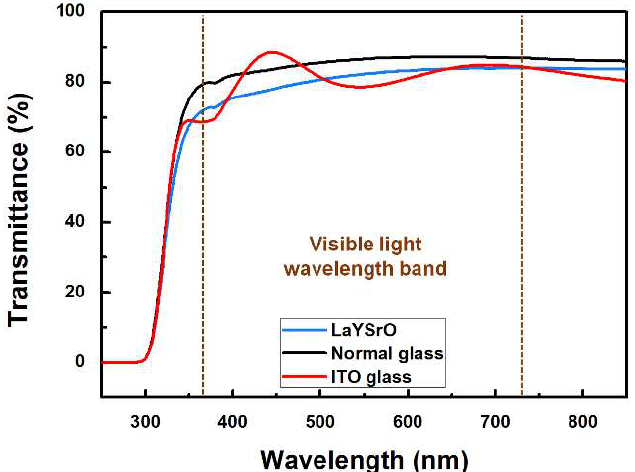
Figure 8. UV transmittance spectra of the brush-coated LaYSrO film cured at 270 °C. Normal and ITO-coated glasses were also measured for comparison. The graphs were obtained in the wavelength range of 250–850 nm, and the band of visible light wavelengths is denoted by the brown dotted lines.